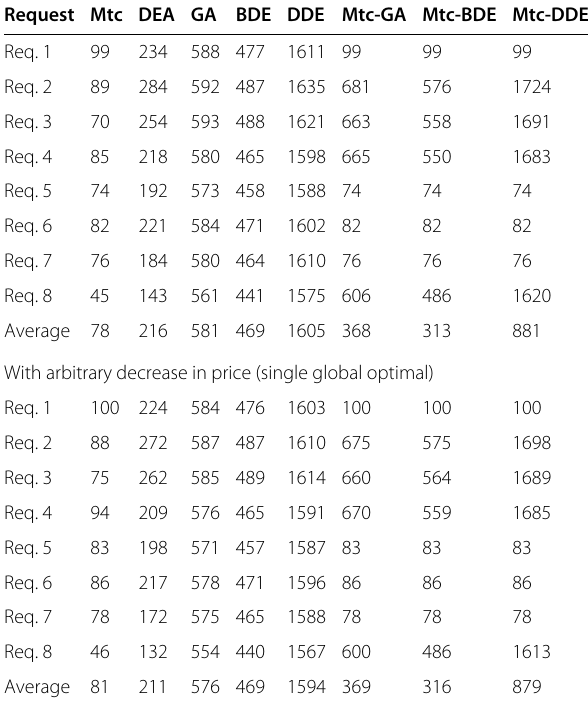
Table 13 Execution time for the developed experiments with 200 CPs, in